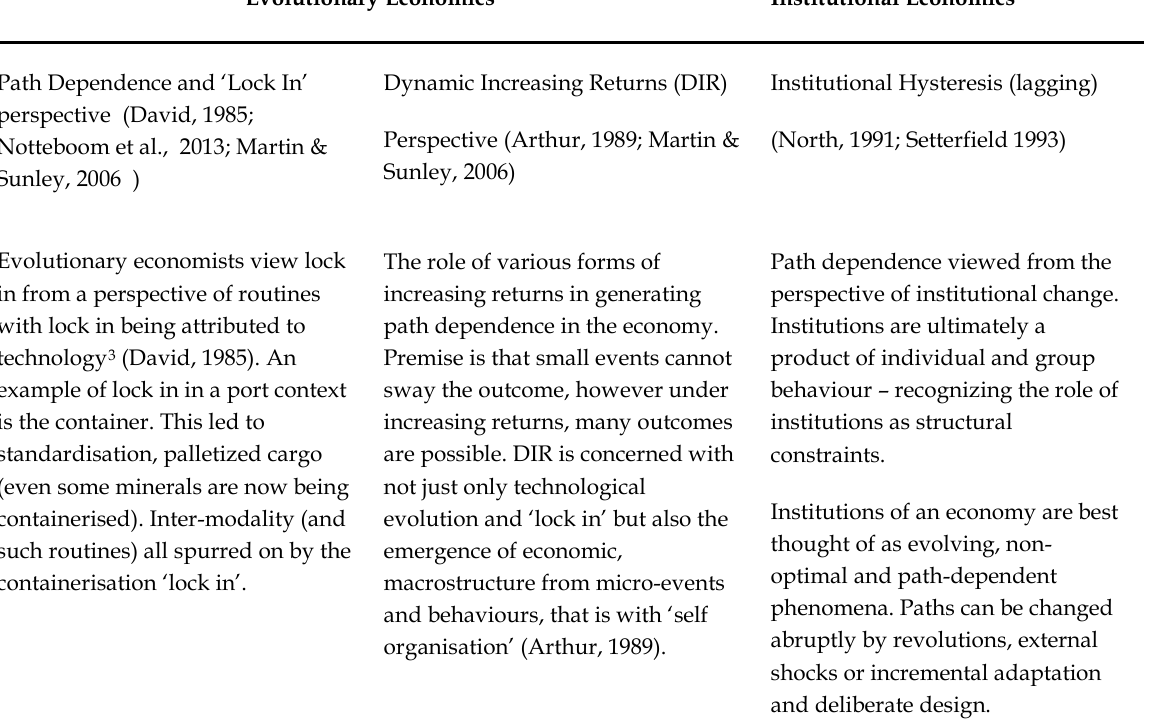
Table 2. Path Dependence